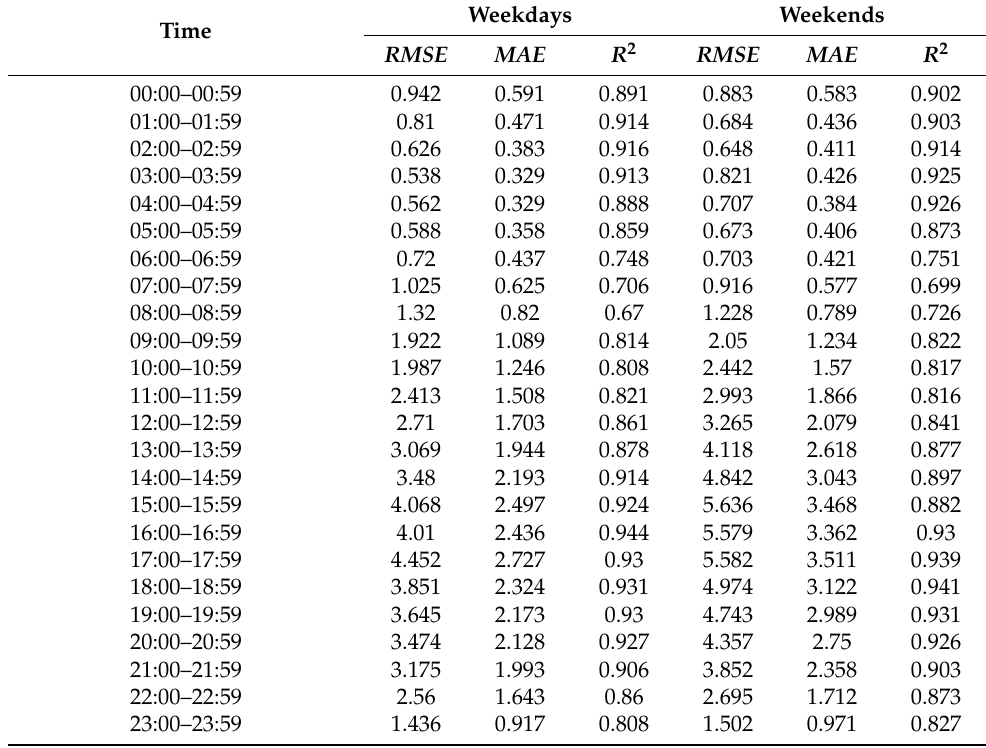
Table 5. The GCN model prediction precision under different